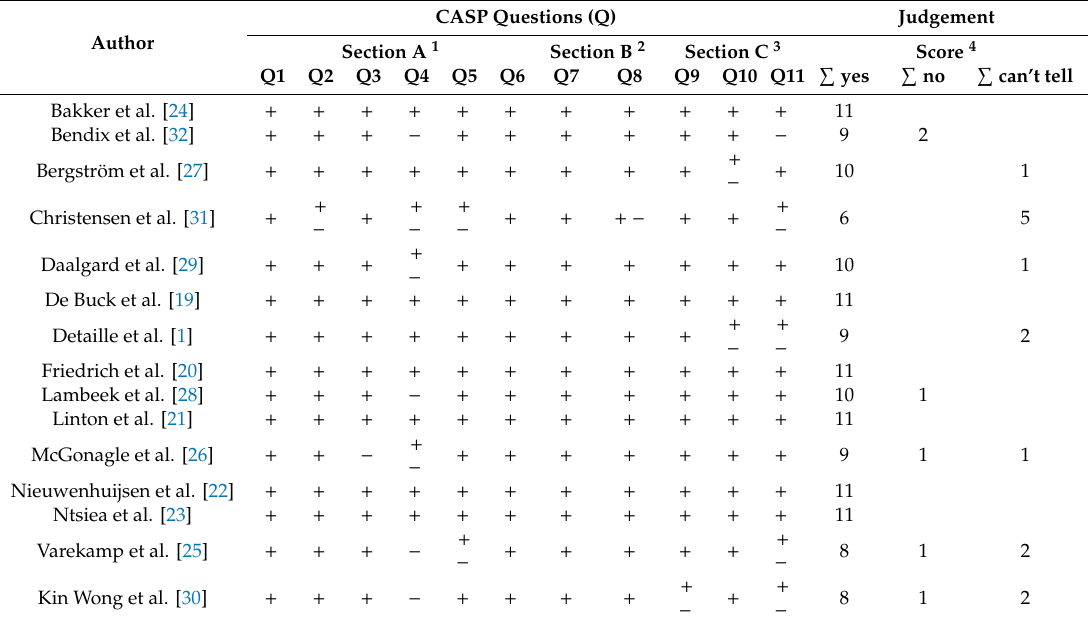
Table 1. Critical Appraisal Skills Program (CASP): Authors agree on methodological quality items for each included